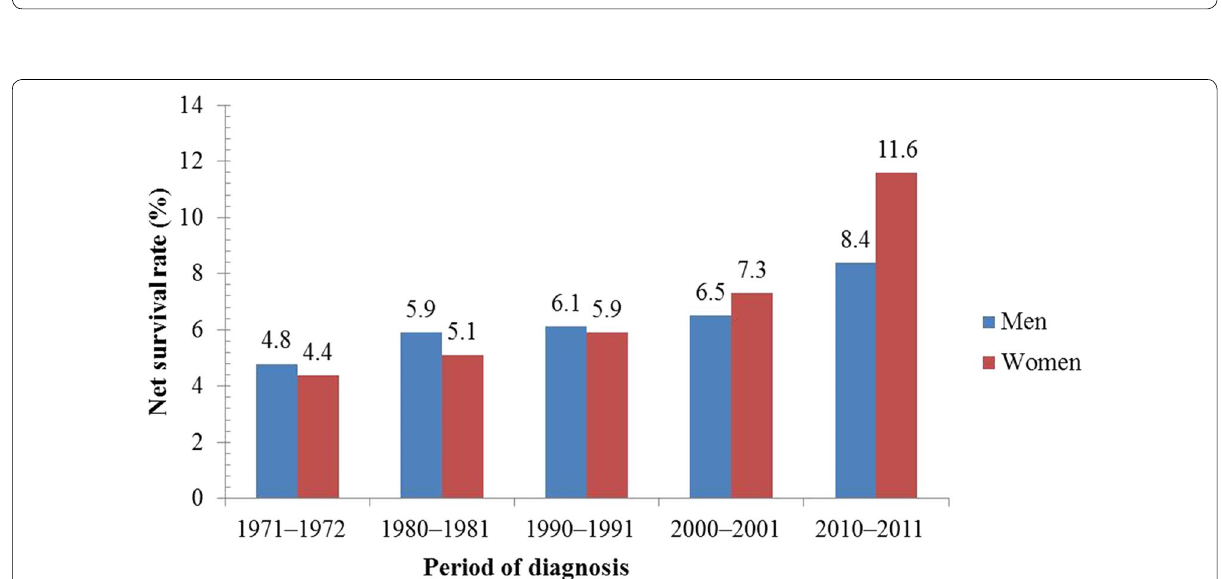
Fig. 2 Five-year net survival trends of lung cancer patients in the UK. During the period 1971–2011, the 5-year age-standardized (age 15–99 years) net survival rates of men with lung cancer has increased from 4.8% to 8.4%; for women, the survival rate increased from 4.4% to 11.6% during